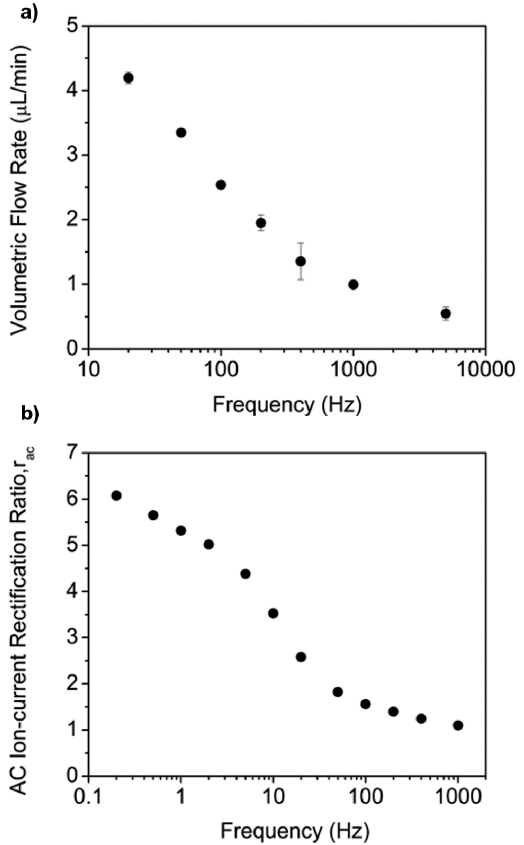
Figure 13. ( a ) Volumetric flow rate as a function of the frequency of the applied sinusoidal voltage with a magnitude of 2.8 V rms . ( b ) Ion current rectification (ICR) ratios as a function of the frequency of the applied sinusoidal voltage with a magnitude of 2.8 V rms . Reproduced with permission from [33]. American Chemical Society, 2016.